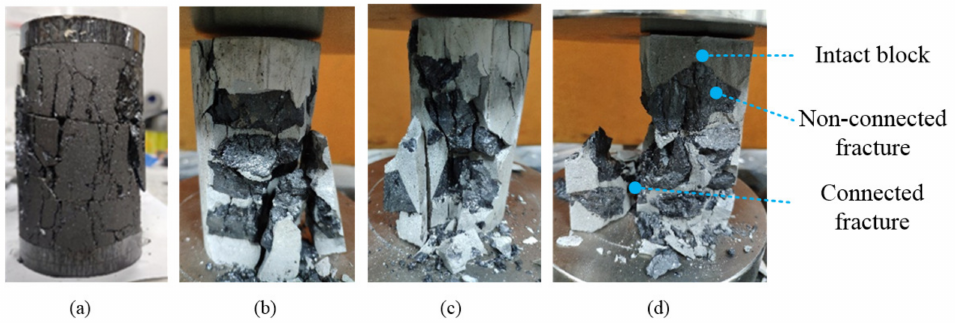
Figure 3. Crack pattern after compression failure of coal and grouted coal. ( a ) Coal; ( b ) Grouted Coal (3d); ( c ) Grouted Coal (7d); ( d ) Grouted Coal